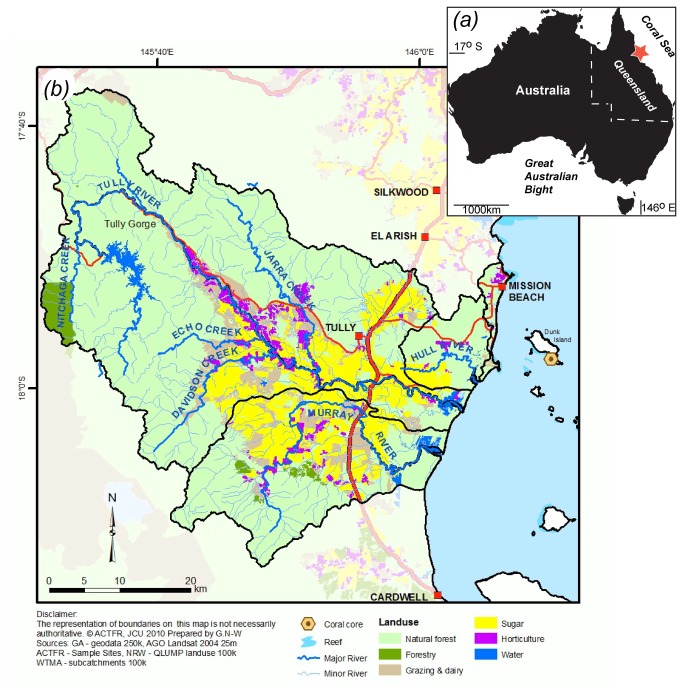
Map detailing (a) the location of the study area (red star) on the east coast of Australia and (b) land-use in the Tully River catchment and the location of Dunk Island coral cores.